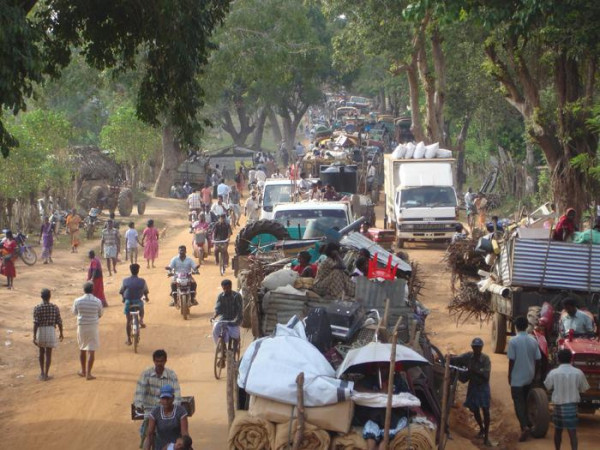
Displacements [79].